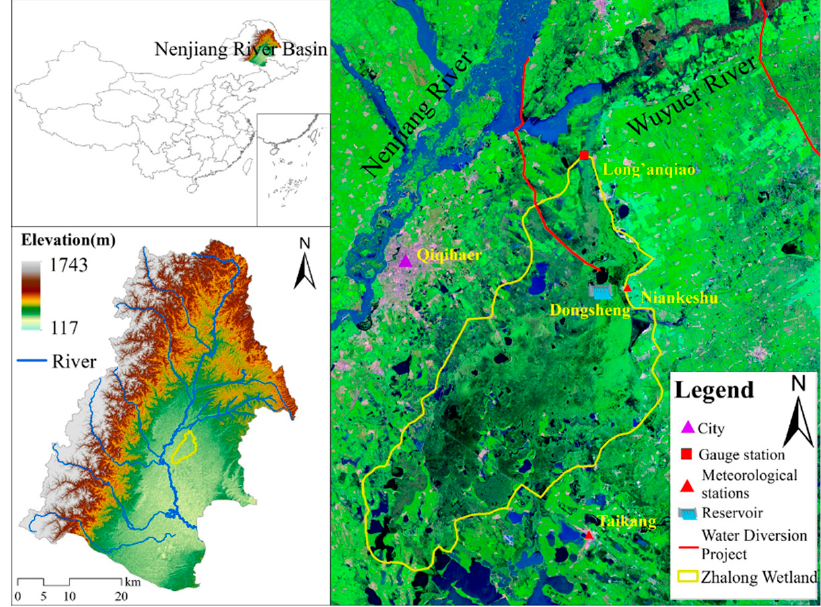
Figure 1. Geographical location of the Zhalong wetland in northeast China and ecological water replenishment